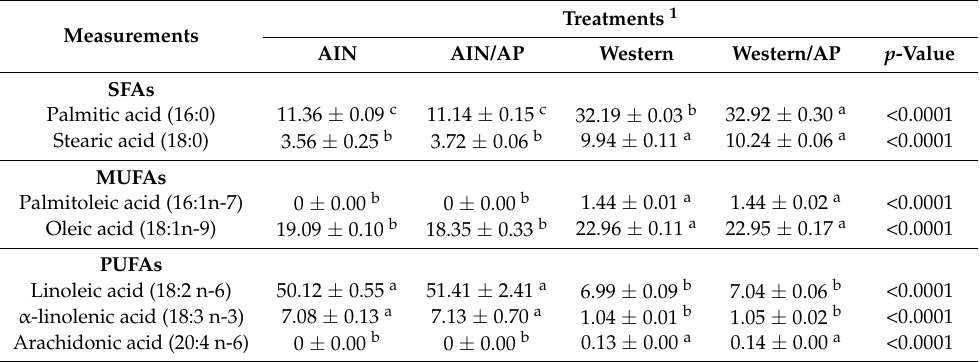
Table 3. Fatty acid analysis of rodent diets substituted with apple pomace (10% g/kg).